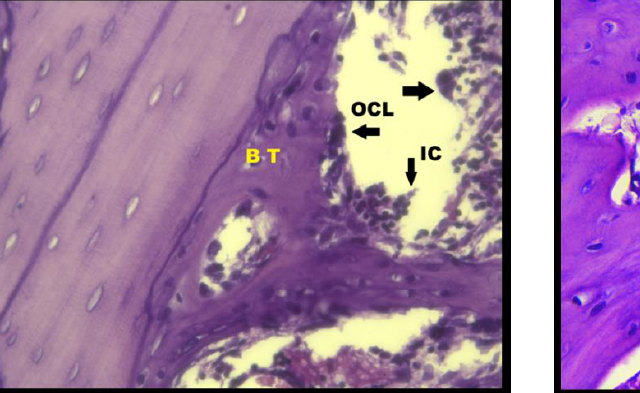
Figure (4): Sponge group at 4-weeks showing regular arrangement of osteocytes (OC) around Haveresian canal (HC) and osteoblasts (OB). H&EX40